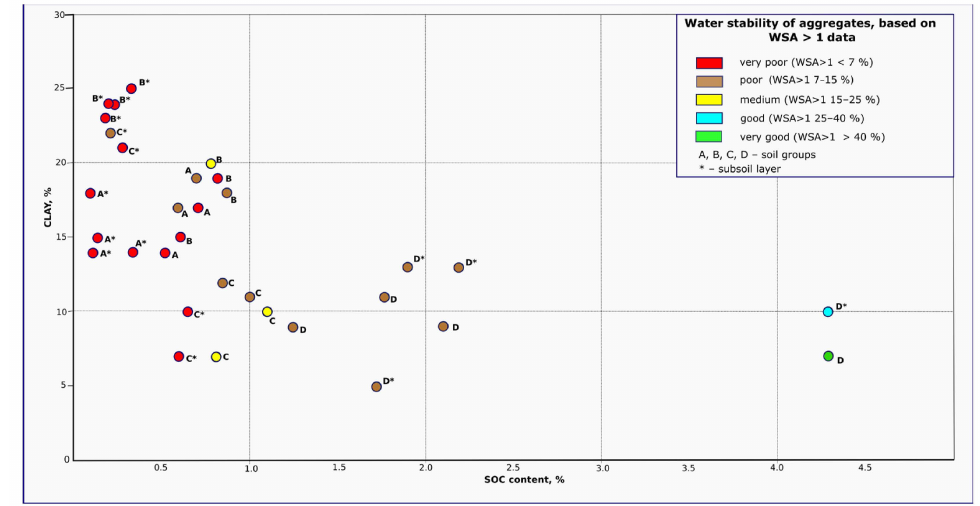
Figure 6. Assessment of aggregate stability in different soils depending on clay and soil organic carbon